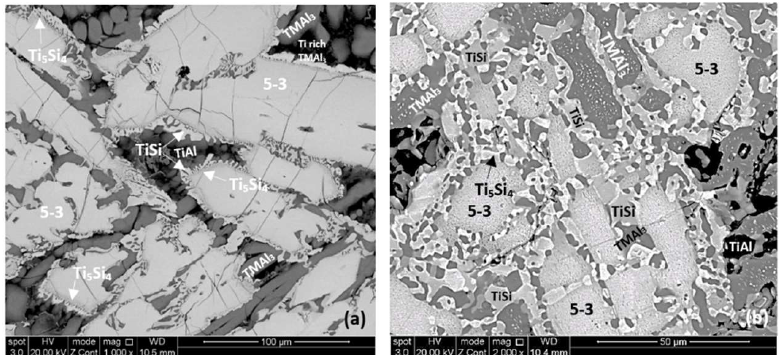
Figure 7. SEM backscatter electron images of the bulk microstructure of the heat treated alloy Nb 1.3 Si 2.4 Ti 2.4 Al 3.5 Hf 0.4 ( a ) 800 ◦ C, ( b ) 1200 ◦